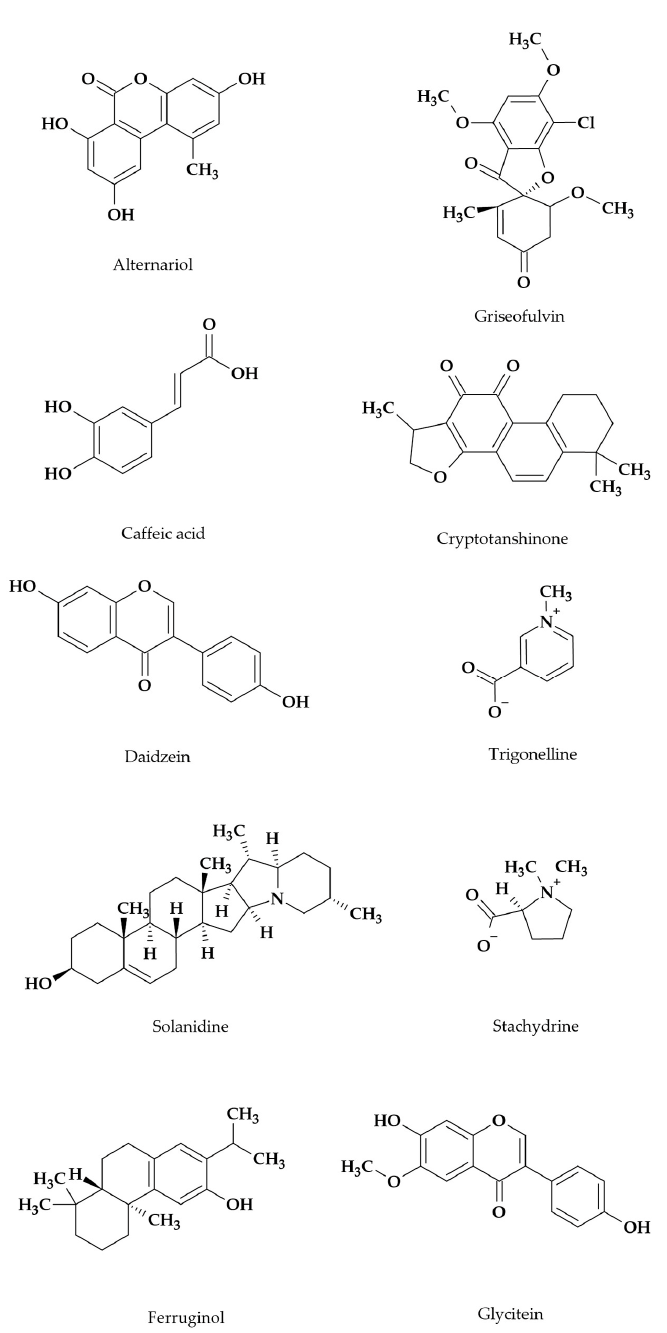
Figure 3. Chemical structure of some bioactive products from endophytic fungi of Salvia spp.